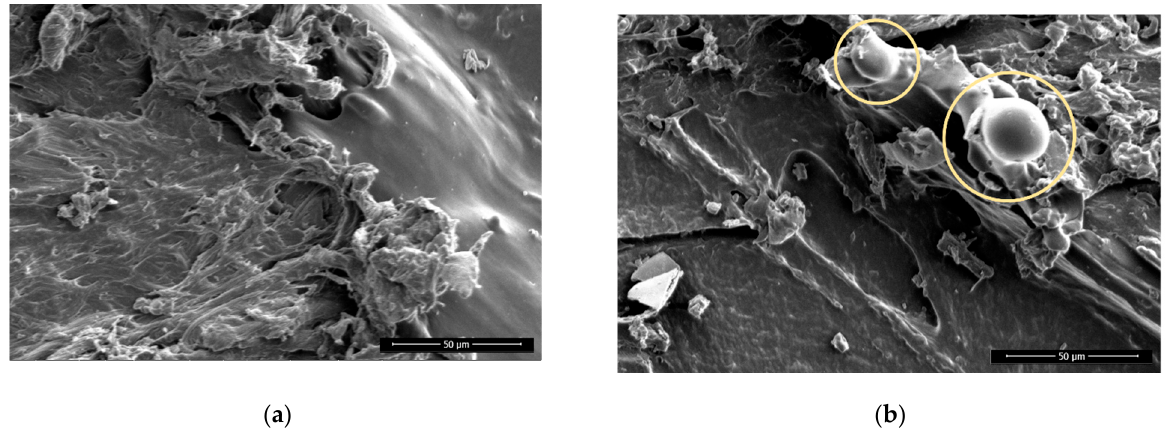
Figure 7. Wood-PLA, sanded, non-treated ( a ) and plasma treated with visible melted particles ( b ), 1000× magnification. Melted particles are encircled.